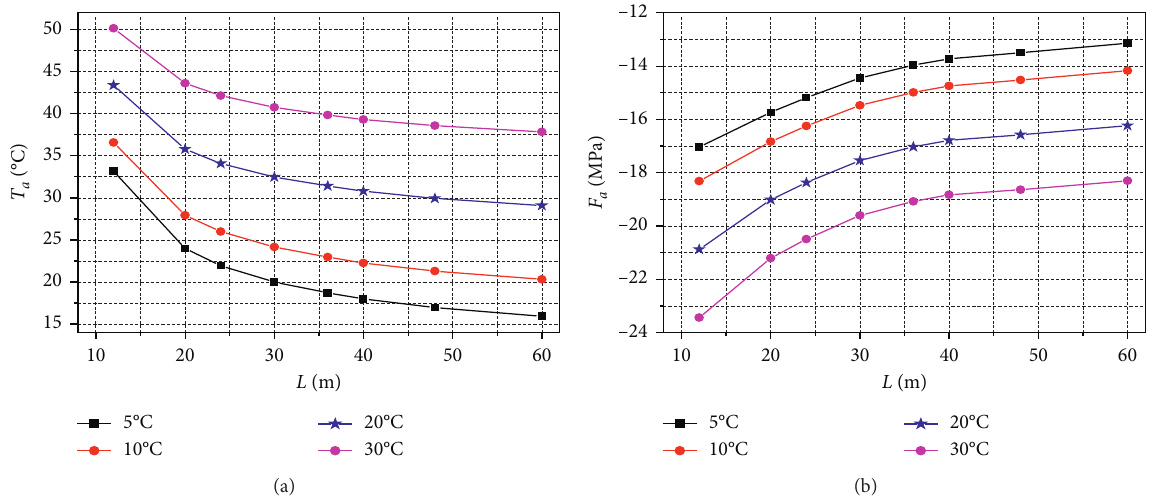
Figure 5: Influence of the side length of different surrounding rock calculation areas on the surrounding rock temperature and stress: influence of L on T a (a) and influence of L on F a